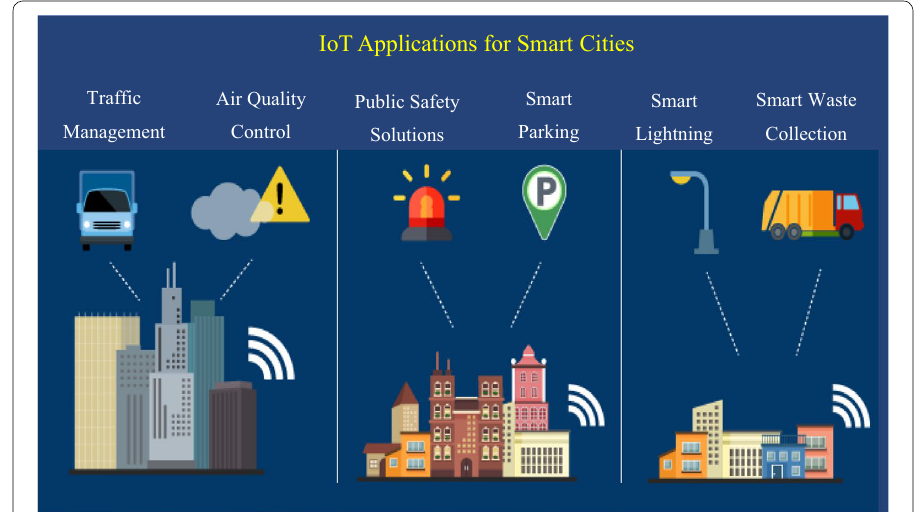
Fig. 5 Potential IoT application areas for smart